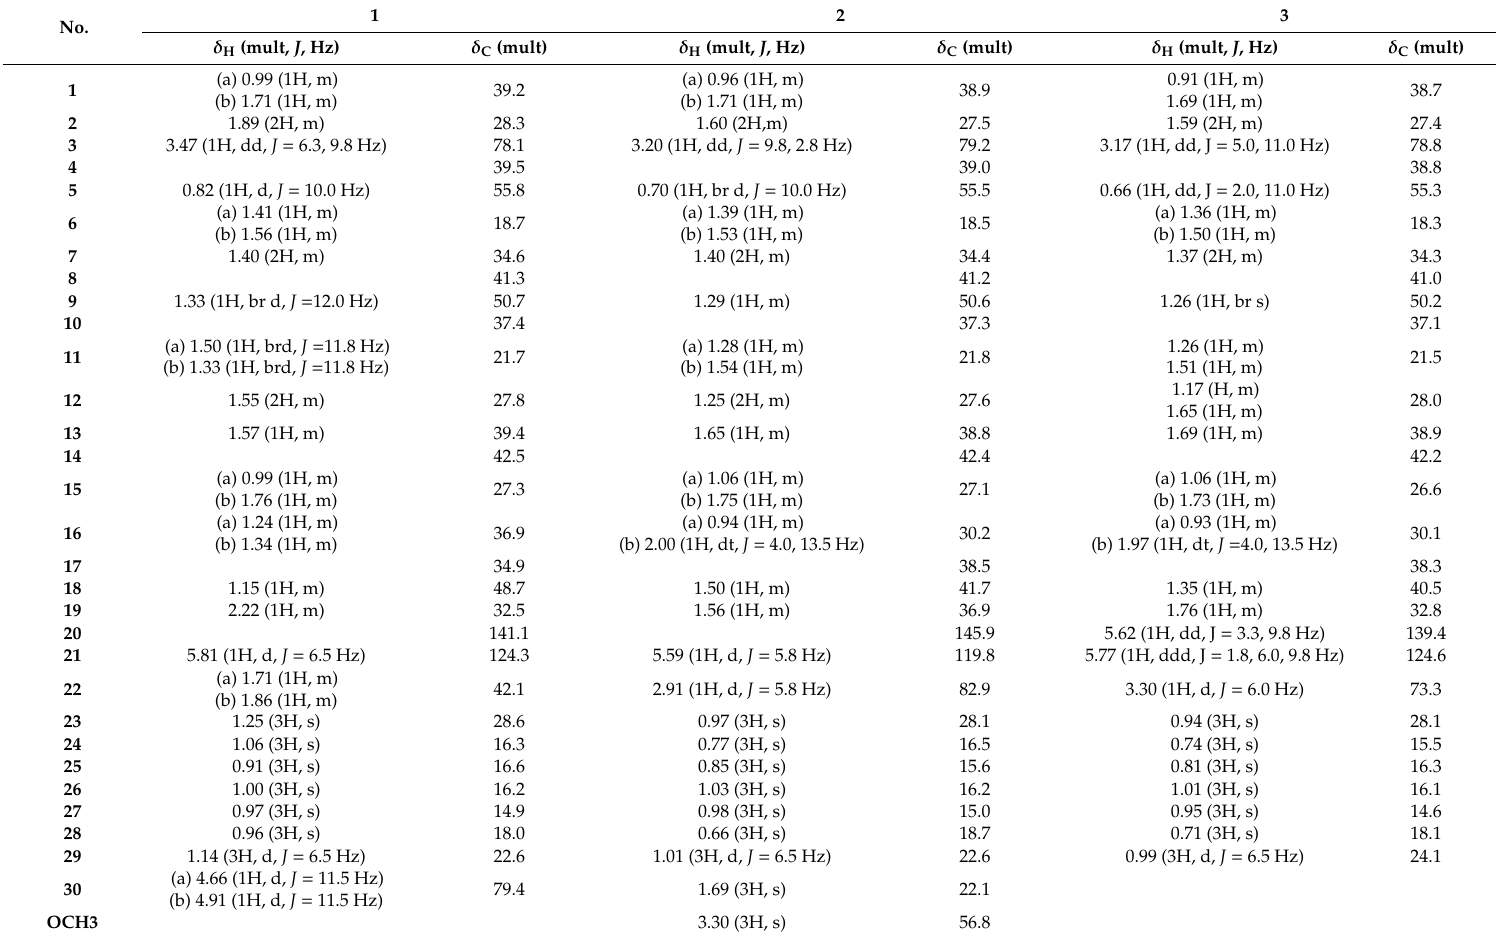
Table 1. 1 H-NMR and 13 C-NMR Data for Compounds 1 – 3 a